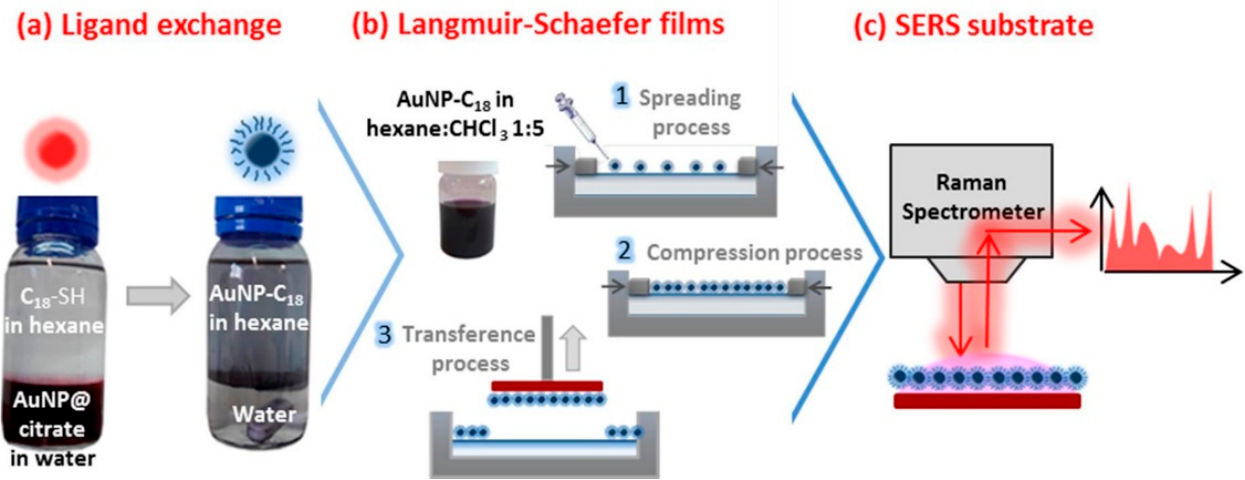
Figure 5. Scheme showing the protocol followed in the work by Lafuente et al.: ( a ) preparation of the gold nanoparticles dispersion, ( b ) fabrication of Langmuir films and Langmuir–Schaefer modified substrates incorporating octadecylthiolate capped gold nanoparticles, ( c ) application of these substrates for SERS detection. Reproduced with permission from [53], Applied Surface Science; pub- lished by Elsevier, 2020.